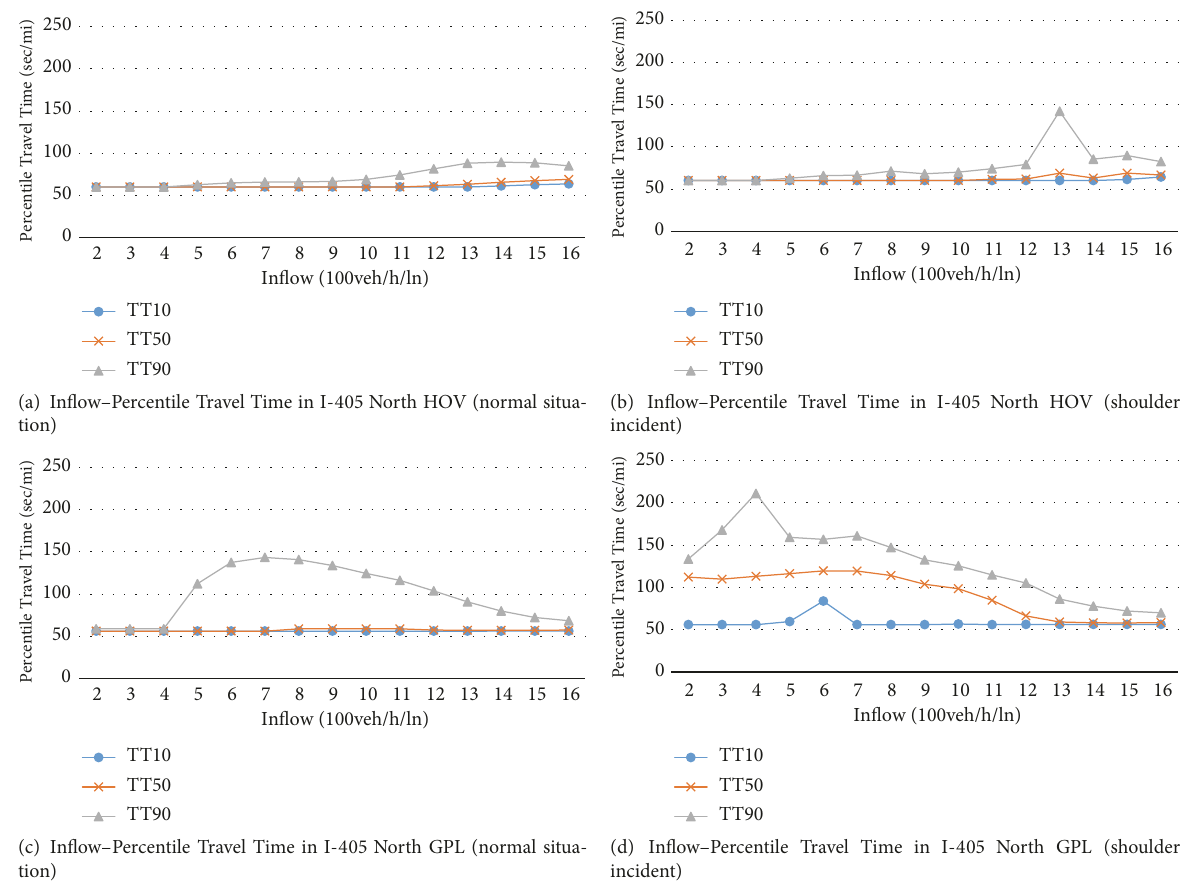
Figure 7: Inflow–Percentiletraveltime functionin I-405North under normal situation and shoulder incident.(a) I-405 North HOV (normal situation). (b) I-405 North HOV (shoulder incident). (c) I-405 North GPL (normal situation). (d) I-405 North GPL (shoulder